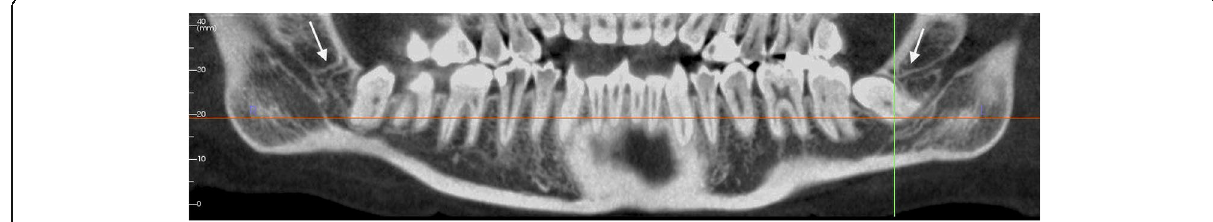
Fig. 1 Slice panoramic view. Slice view of reconstructed panoramic image, the two white arrows pointing to the RMC